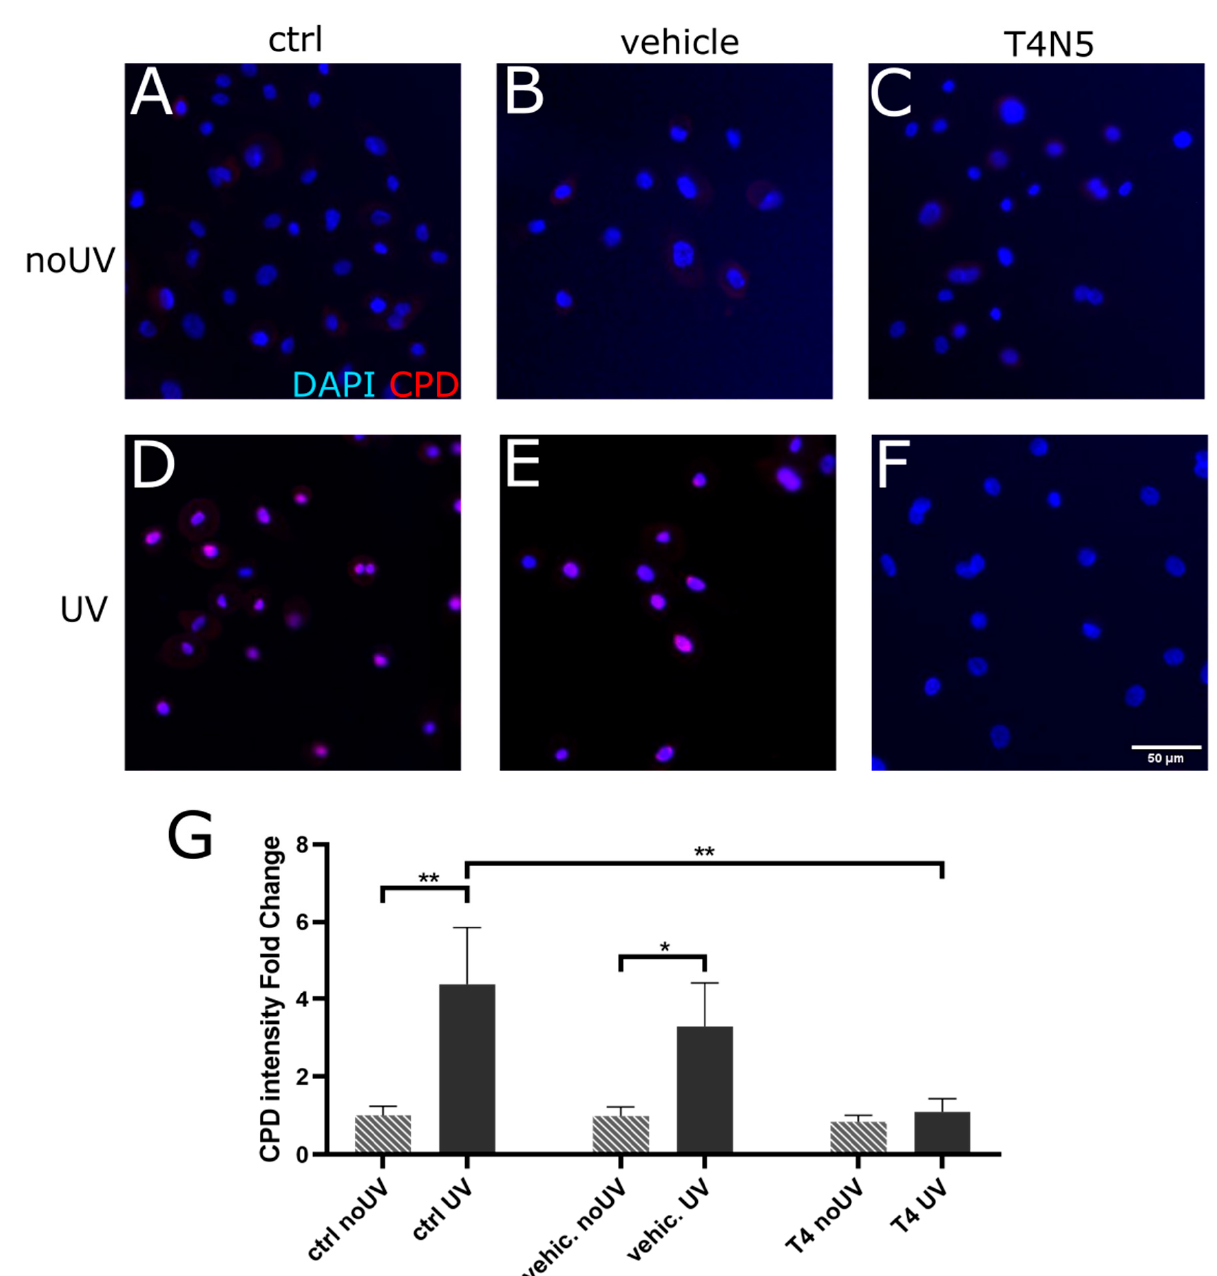
Figure 1. Mean fluorescence intensity of CPDs in human limbal epithelial cells; comparing untreated controls ( A , D ) (ctrl), vehicle controls ( B , E ) (vehic.), and T4 endonuclease V treatment ( C , F ) (T4). Cells were either irradiated with UVB ( D – F ) (UV) or not irradiated ( A – C ) (no UV). The mean fluorescence intensity of CPDs ( G ) was measured 48 h after 0.03 J/cm 2 UVB; n = 3. CPD immunofluorescence was highest in irradiated cell that did not have T4 endonuclease V ( p < 0.0001). * indicates p < 0.05, ** indicates p < 0.002.